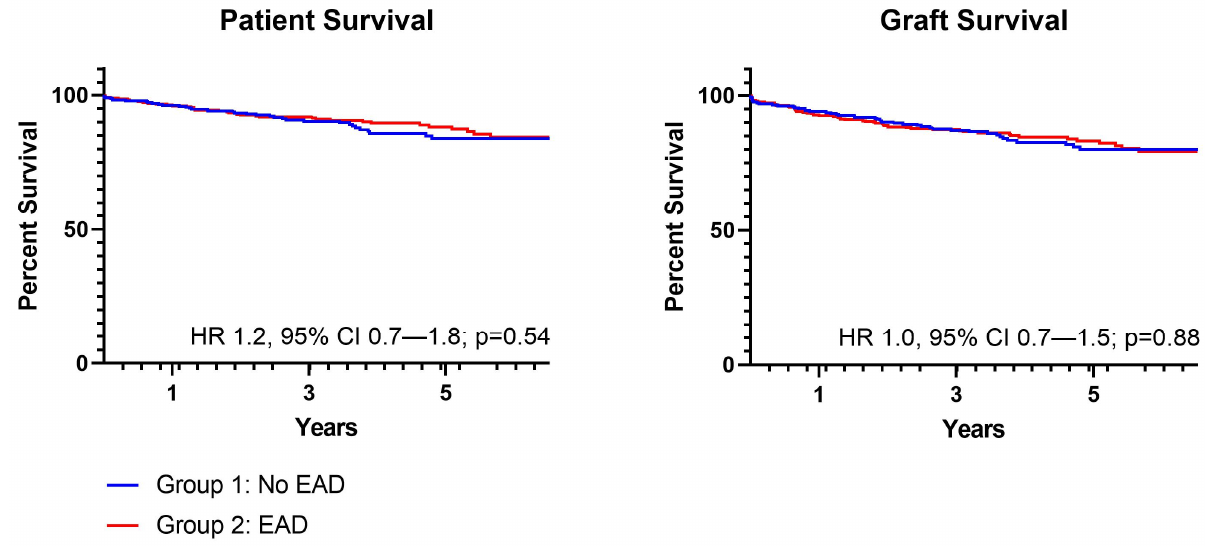
Figure 1. Patient and graft survival.